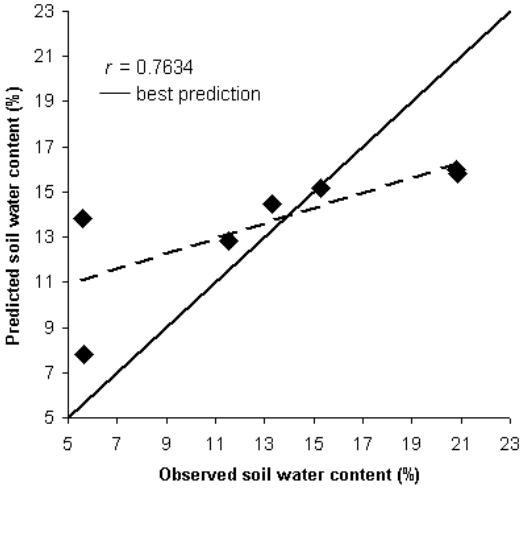
Figure 3. Regression between observed and predicted values of soil water content for the intervals t slope in the independent test for the thermometric analysis ( i.e. , 15% of whole 10 sample